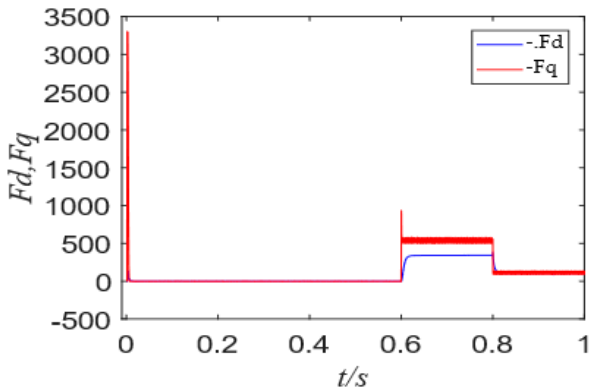
Figure 12. Torque of FCS-MFPCC.